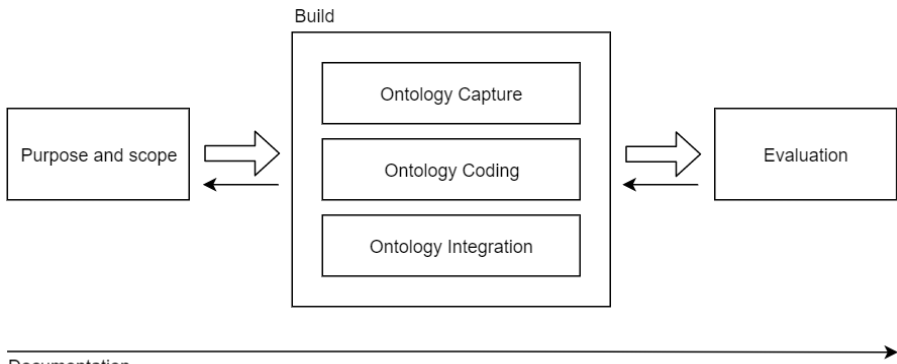
Figure 1. Representation of the skeletal methodology used during the development of AD-DPC. The figure is based on the original methodology proposed by Unschold and Gruninger.